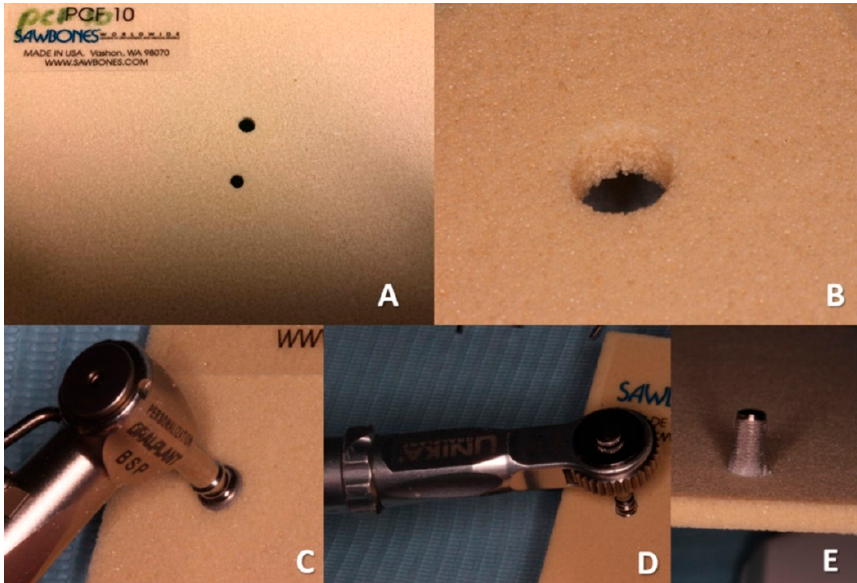
Figure 4. Test Group. ( A ) Polyurethane Block drilling holes. ( B ) Aspect of site preparation after drilling. ( C ) Placement of the Sinus Implant by the surgical motor at 1 mm from the block level. ( D ) Placement of the fixture for the last 1 mm with a manual ratchet. ( E ) Aspect of the backside of the preparation.